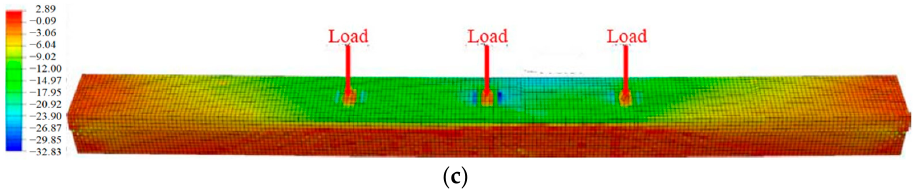
Figure 14. Stress diagrams of the concrete. ( a ) The undamaged #3-2 girder; ( b ) The repaired #3-2 girder strengthened by steel plates; ( c ) The damaged #3-2 girder.